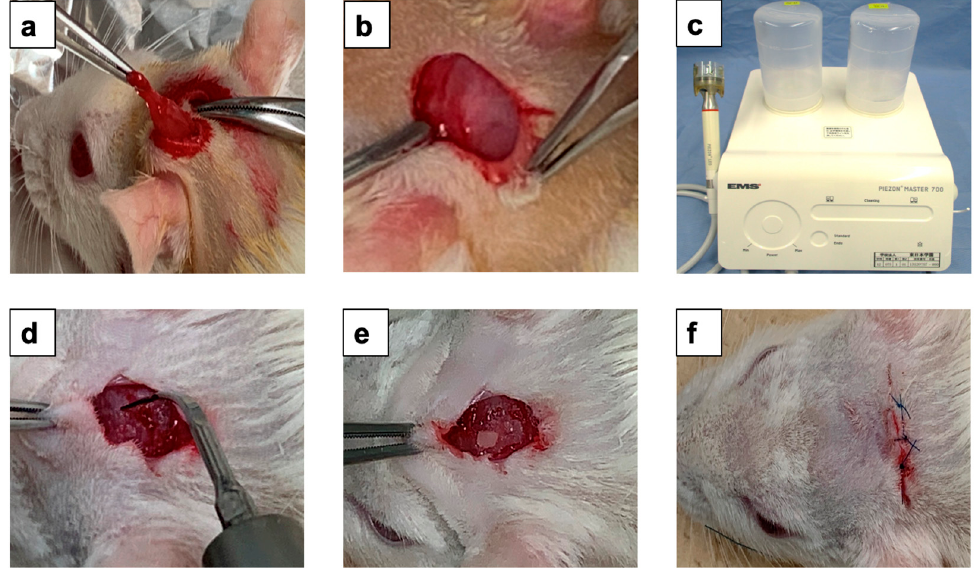
Figure 2. Schematic representation of ultrasonic scaler scratching design and PDDM graft in experimental group. ( a ) Periosteum removed from parietal bone after the elevation of scalp, ( b ) Exposed parietal bone, ( c ) Piezoelectric ultrasonic scaler unit, operated at 24–32 kHz, 8–12 Watt for 1 min, ( d ) Exposed parietal bone treated by ultrasonic scaler tip for 1 min, ( e ) PDDM onlay graft on scratched skull and ( f ) Skin sutured with 4/0 polyglactin resorbable sutures. PDDM: Partially demineralized dentin matrix.